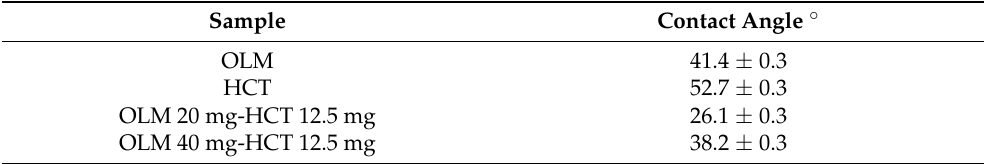
Table 1. Contact angle